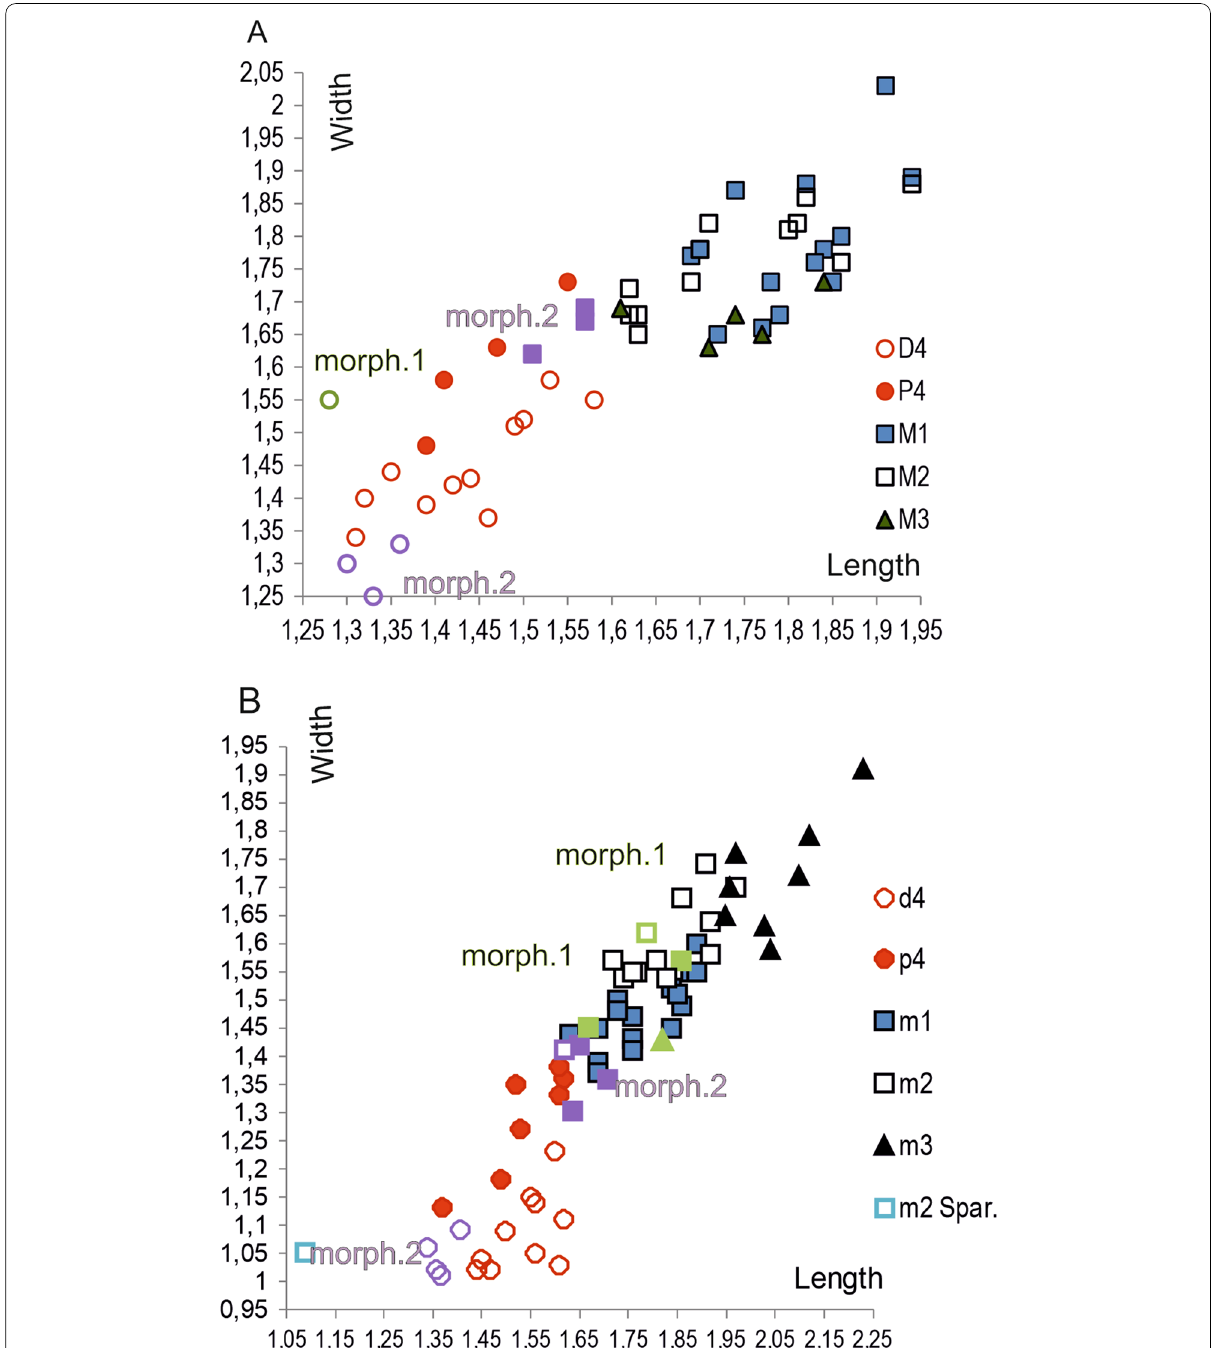
Fig. 43 Bivariate graph (width/length) of the upper ( A ) and lower (B) teeth of ? Protadelomys maximini Escarguel, 1998 from Saint‑Maximin (Gard) (dp4/DP4 and p4/P4: red marks; upper and lower molars: black and blue marks). From Saint‑Maximin, a few teeth are identified as ?P. cf. maximini sp. indet. 1 (green marks) and sp. indet. 2 (light purple). On B , a turquoise blue mark corresponds to the small m2 identified as Sparnacomys (Remy et al.